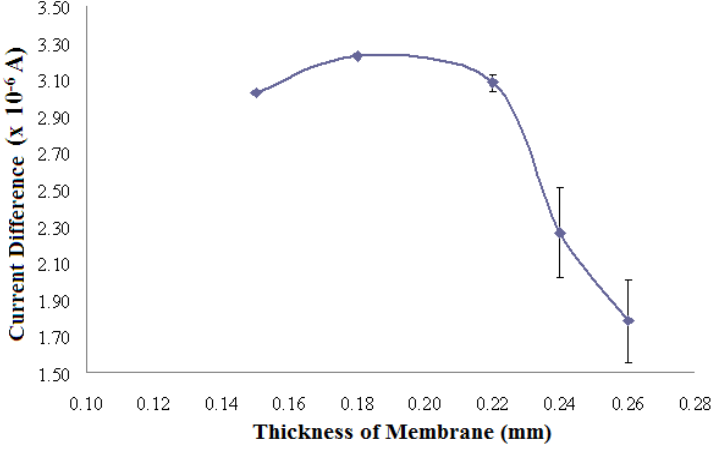
Figure 6. Effect of membrane thickness on the biosensor response in a solution containing 100 mM NH 4+ ion at pH 7 (n = 3).